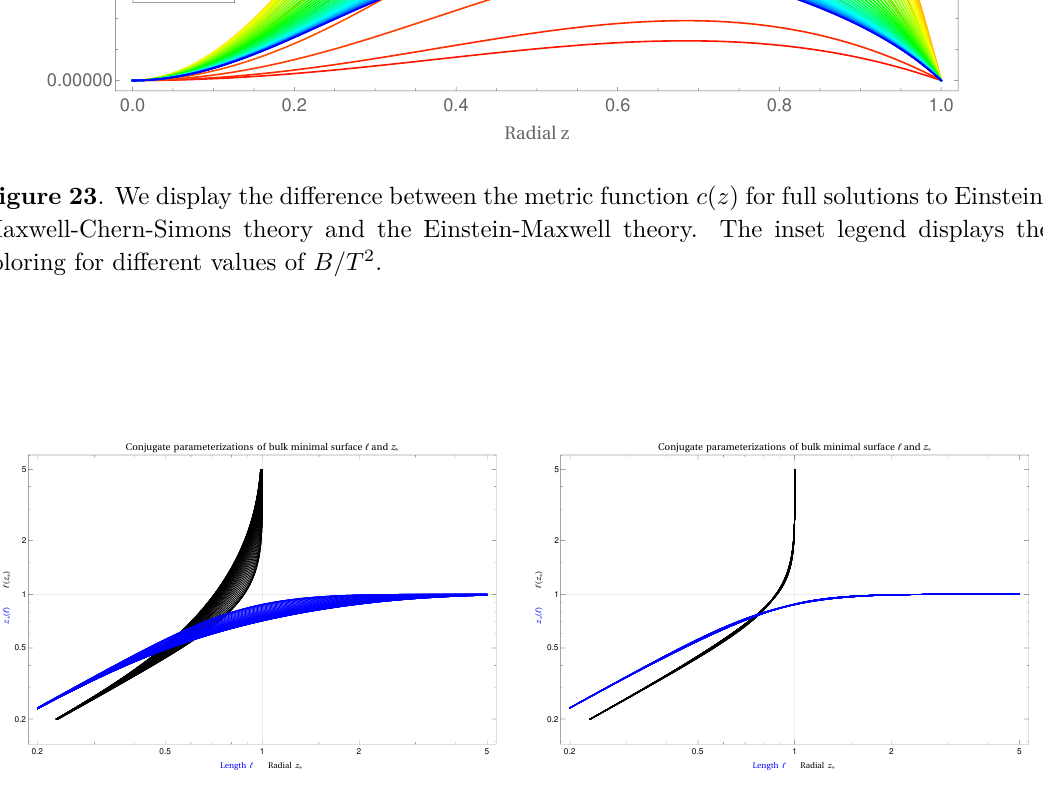
Figure 24 . The conjugate variables ‘ and z ∗ are displayed for bulk minimal surfaces with γ = 0 for a range of magnetic field values. Left: parallel strips with embedding coordinates ( z ( σ ) , t ( σ ) , x 3 ( σ )) . Right: transverse strips with embedding coordinates ( z ( σ ) , t ( σ ) , x 1 ( σ )) . Despite displaying the figure on a log-log scale the deviations due to change in magnetic field values is vary small for strips in the transverse directions. While noticeable variation occurs for strips oriented in the parallel